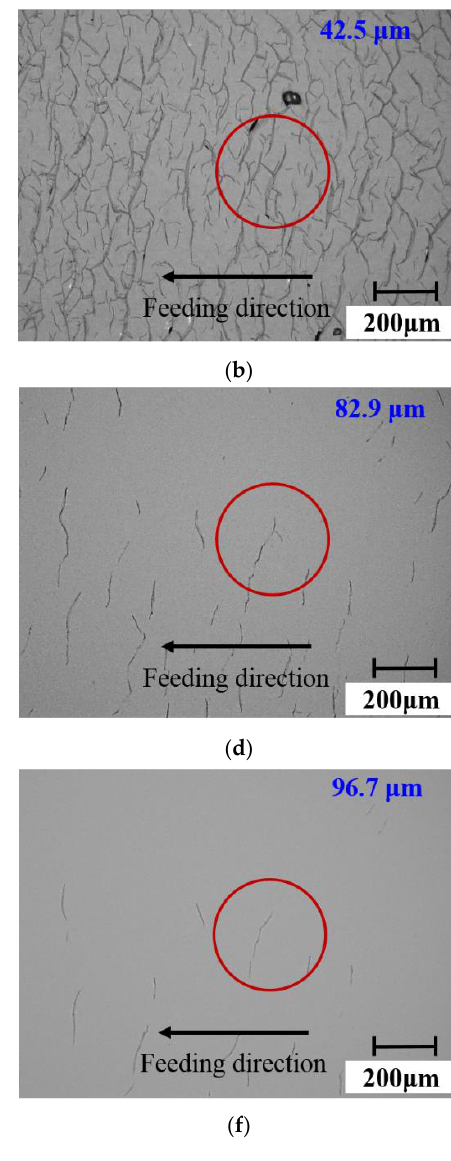
Figure 7. Distribution characteristics of cracks at different subsurface depths under the action of the undressed wheel, subsurface depth ( a ) 0 μm ( b ) 40.7 μm ( c ) 71.1 μm ( d ) 98.6 μm ( e ) 103.4 μm ( f ) 111 μm. The red circle positions in the figure show the variation in a bifurcation crack with subsurface depth.